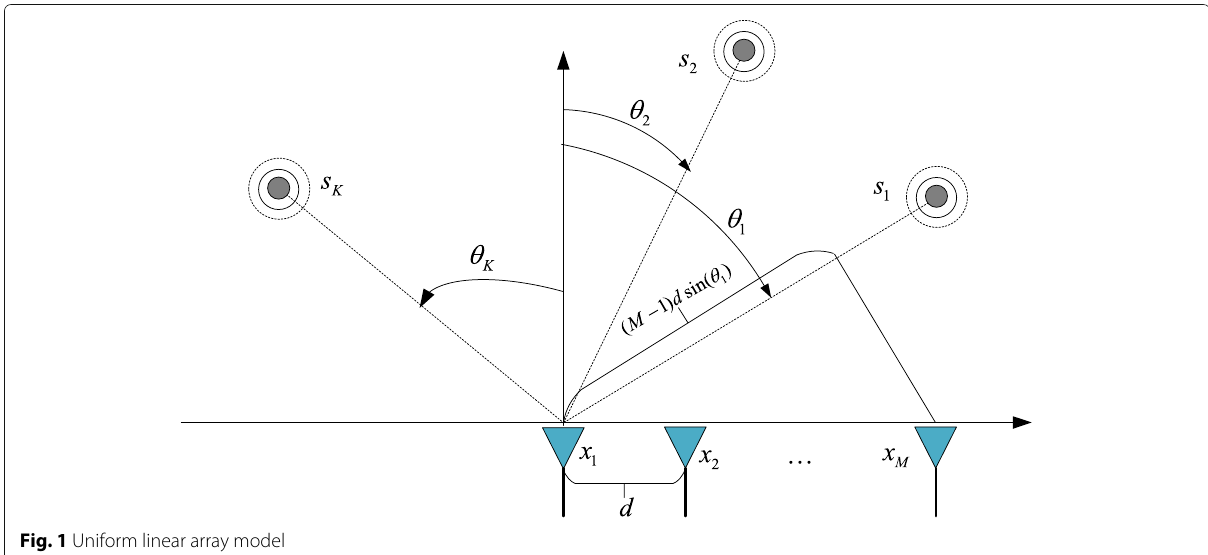
Fig. 1 Uniform linear array